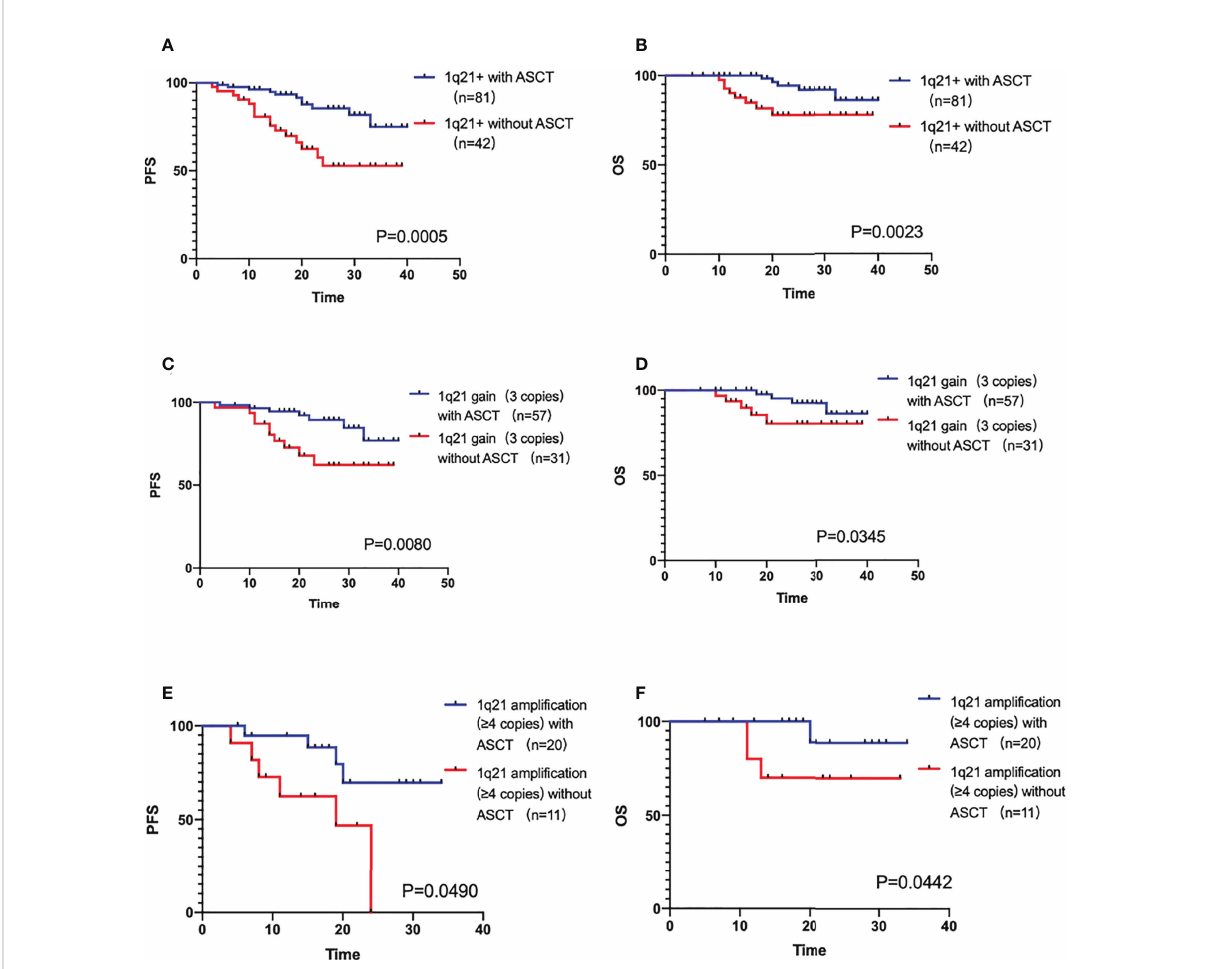
FIGURE 3 (A, B) The PFS and OS comparison of 1q21+ patients with ASCT and without ASCT. (C, D) The PFS and OS comparison of 1q21 gain patients with ASCT and without ASCT. (E, F) The PFS and OS comparison of 1q21 ampli fi cation patients with ASCT and without